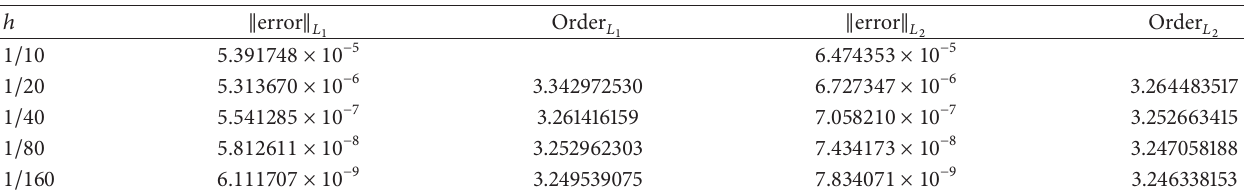
Table 4: The error between the numerical solutions and the exact solution of the problem (109); 𝛼 = 0.75 , 𝜙 1 = 0.95, 𝜙 2 = 0.99 . ℎ ‖ error ‖ 𝐿 1 Order 𝐿